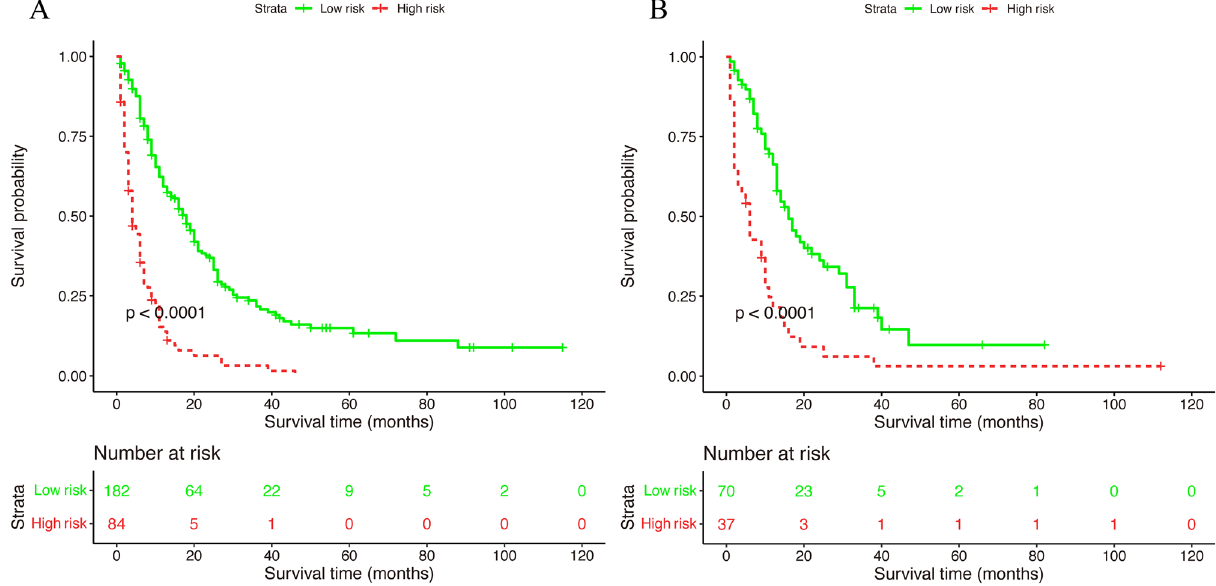
Figure 5. Kaplan–Meier survival curves of nomogram for OS in the training cohort ( A ) and validation cohort ( B ). OS, overall survival.